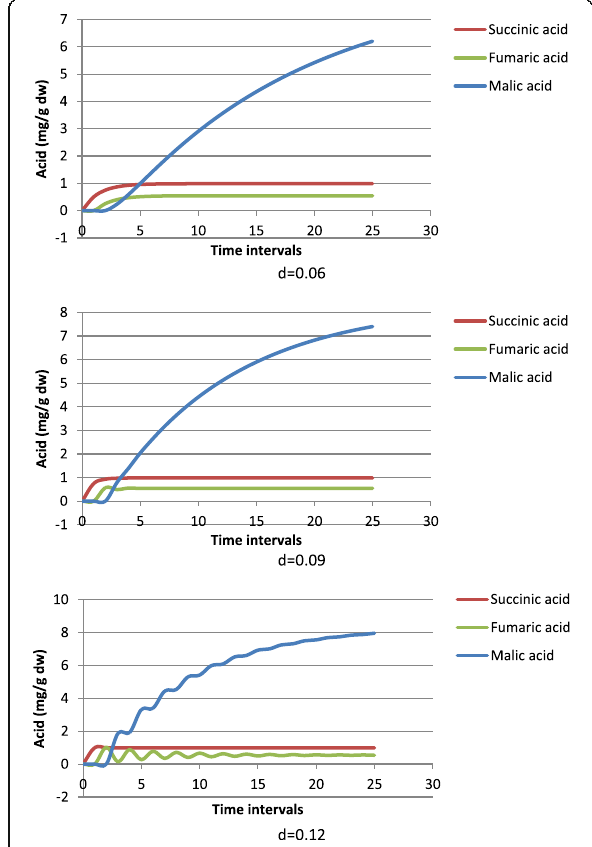
Fig. 6 Simulation of organic acid concentrations by using different rates of utilization of malic acid (d). Higher values of “ d ” cause oscillatory behavior, and d (0.09) stabilizes the system fast